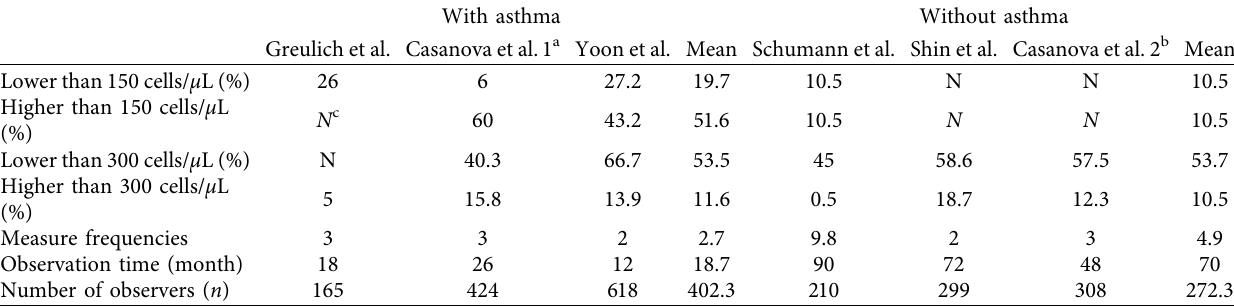
Table 1: Results of BEC level with or without asthma. With